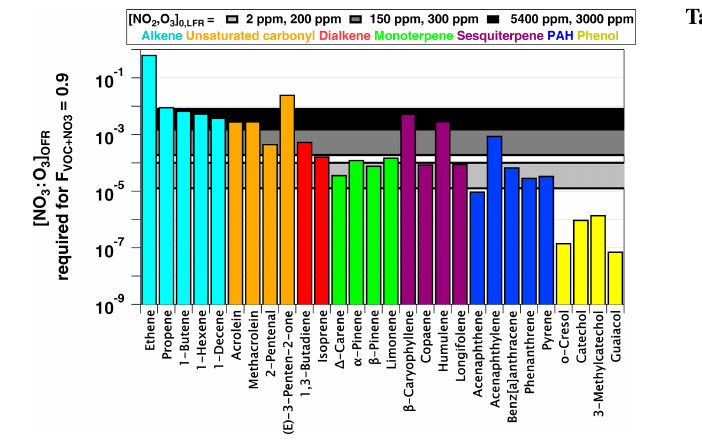
= 0 . 9 for representative Figure 9. NO 3 : O 3 at which F VOC + NO 3 > 10 − 19 cm 3 molecules − 1 s − 1 > 10 − 16 and k O VOCs with k NO 3 3 (Manion et al., 2015). Horizontal bands represent upper and lower = 0 . 01 and 0.08s − 1 . limit values calculated assuming k w , N 2 O 5